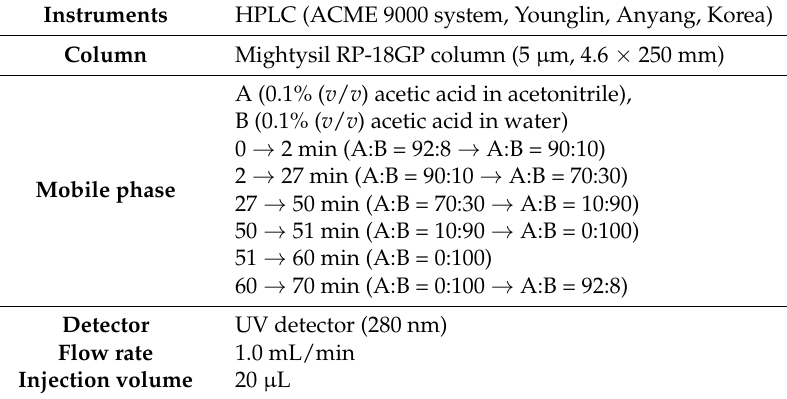
Table 1. High-performance liquid chromatographic (HPLC) conditions for the analysis of phenolic acid.